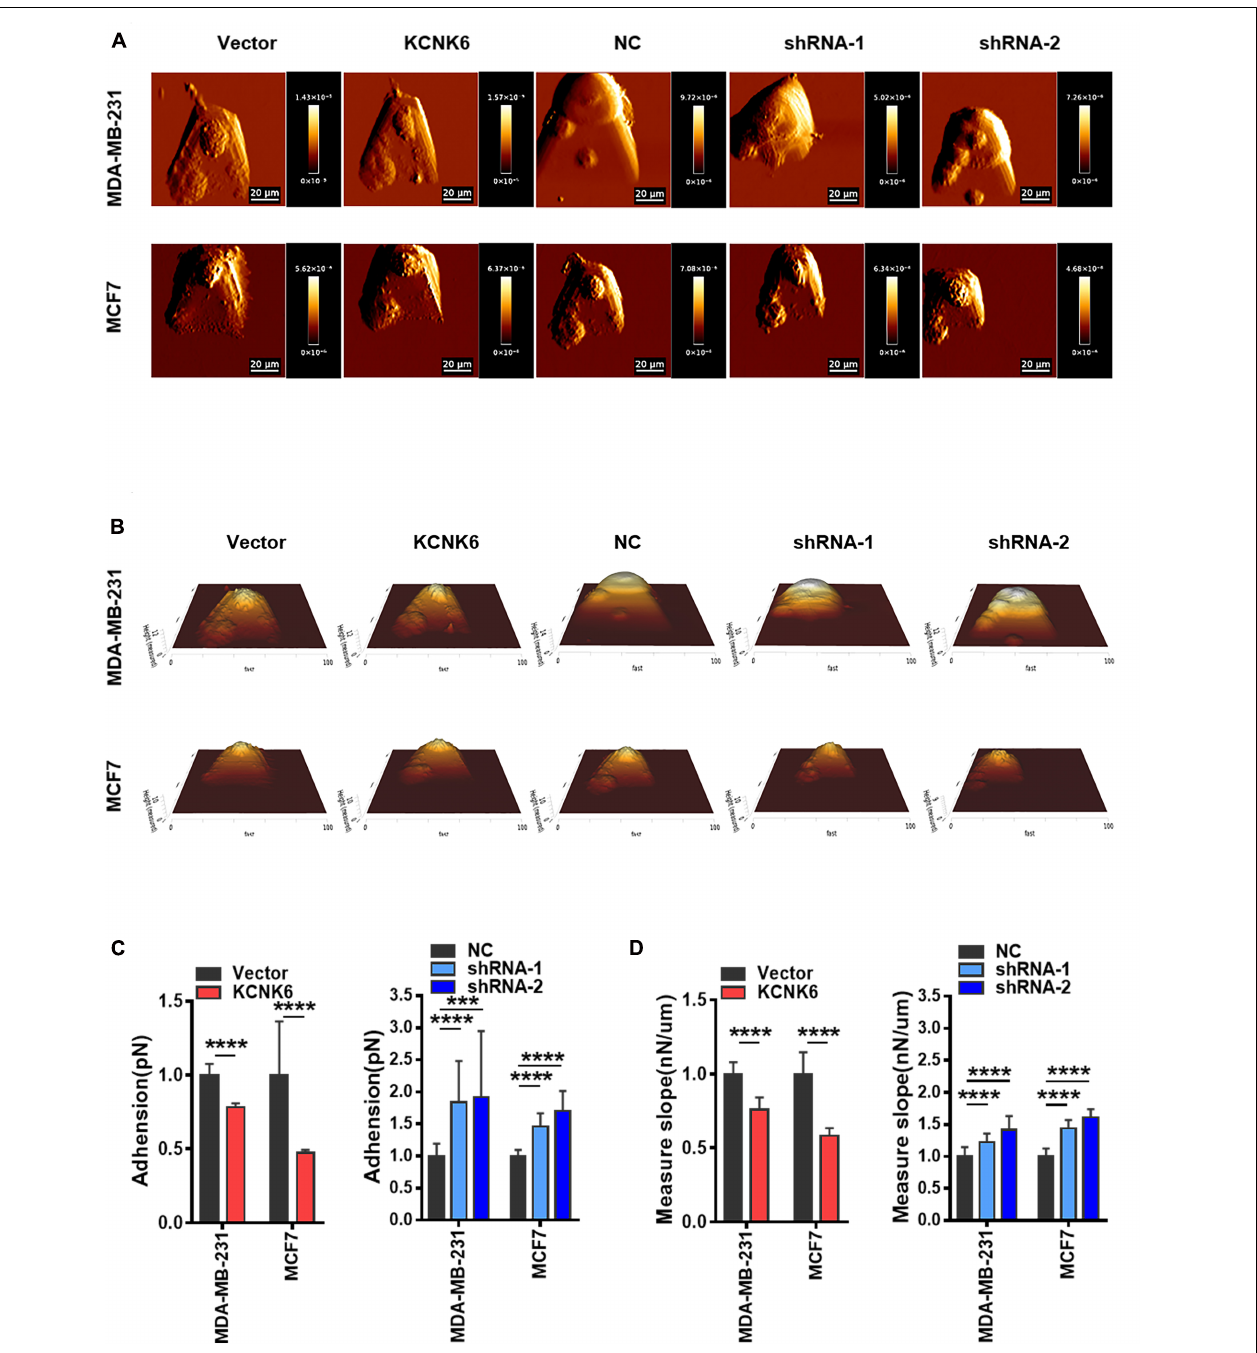
FIGURE 4 | KCNK6 expression affects the biophysical properties of breast cancer cells. (A) Representative AFM deflection images of MDA-MB-231 cells and MCF-7 cells in control group, overexpression KNCK6 group and knocked down KCNK6 group. The cells of each group were fixed in a petri dish, and were selected randomly for detection by atomic force microscopy (AFM). (B) Representative three-dimensional height distribution map of MDA-MB-231 cells and MCF-7 cells in control group, overexpression KNCK6 group and knock down KCNK6 group, the detection method is the same as above. (C) Thirty cells were randomly selected form each group, and the adhesion was statistically analyzed and plotted based on JPK image processing software. High levels of KCNK6 could weaken the adhesion between MDA-MB-231 cells and MCF-7 cells, while low levels of KCNK6 increased the adhesion between cells. (D) Thirty cells were randomly selected from each group, and their stiffness was statistically analyzed and plotted based on JPK image processing software. Overexpression of KCNK6 significantly reduced the stiffness of MDA-MB-231 and MCF-7 cells, while knocking down KCNK6 could significantly increase the stiffness of cells. *** P < 0.001; **** P < 0.0001.